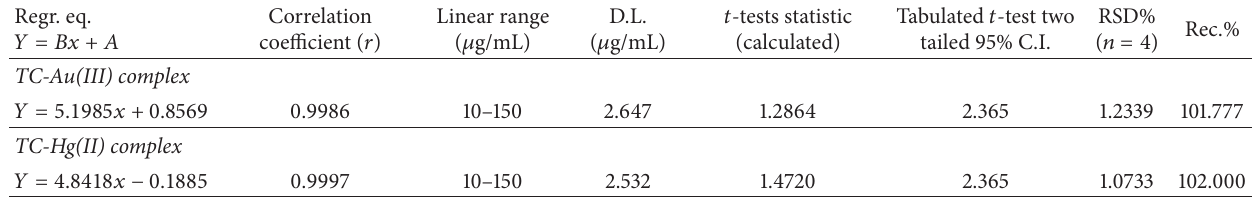
Table 7: Regression equation, correlation coefficient, 𝑡 -test concentration ranges, detection limits, and RSD% for TC-Au(III) and TC-Hg(II) complexes by